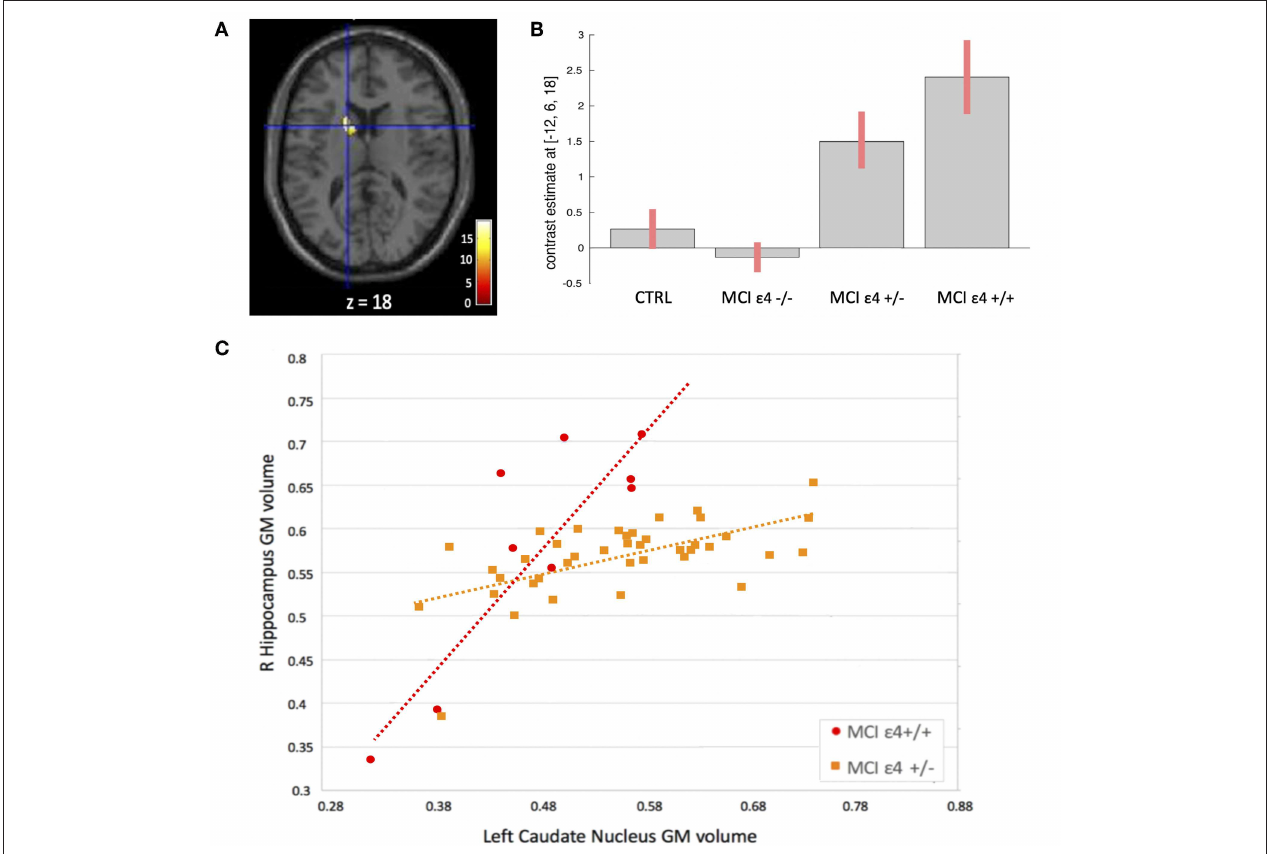
FIGURE 3 | (A) Voxels that expressed the difference in structural association between the right hippocampus and the left caudate nucleus among the groups. (B) Plots depicting mean differences among the groups within region of statistical significance in structural covariance analysis. (C) Correlations between gray matter (GM) volumes extracted from 4-mm radius sphere centered on the ROI and the peak voxel expressing increased structural association in the MCI ε 4 + / + and in MCI ε 4 + / −